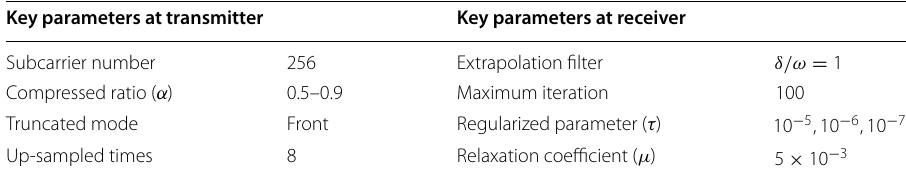
Table 2 Simulation parameter setting for compressive OFDM system Key parameters at transmitter